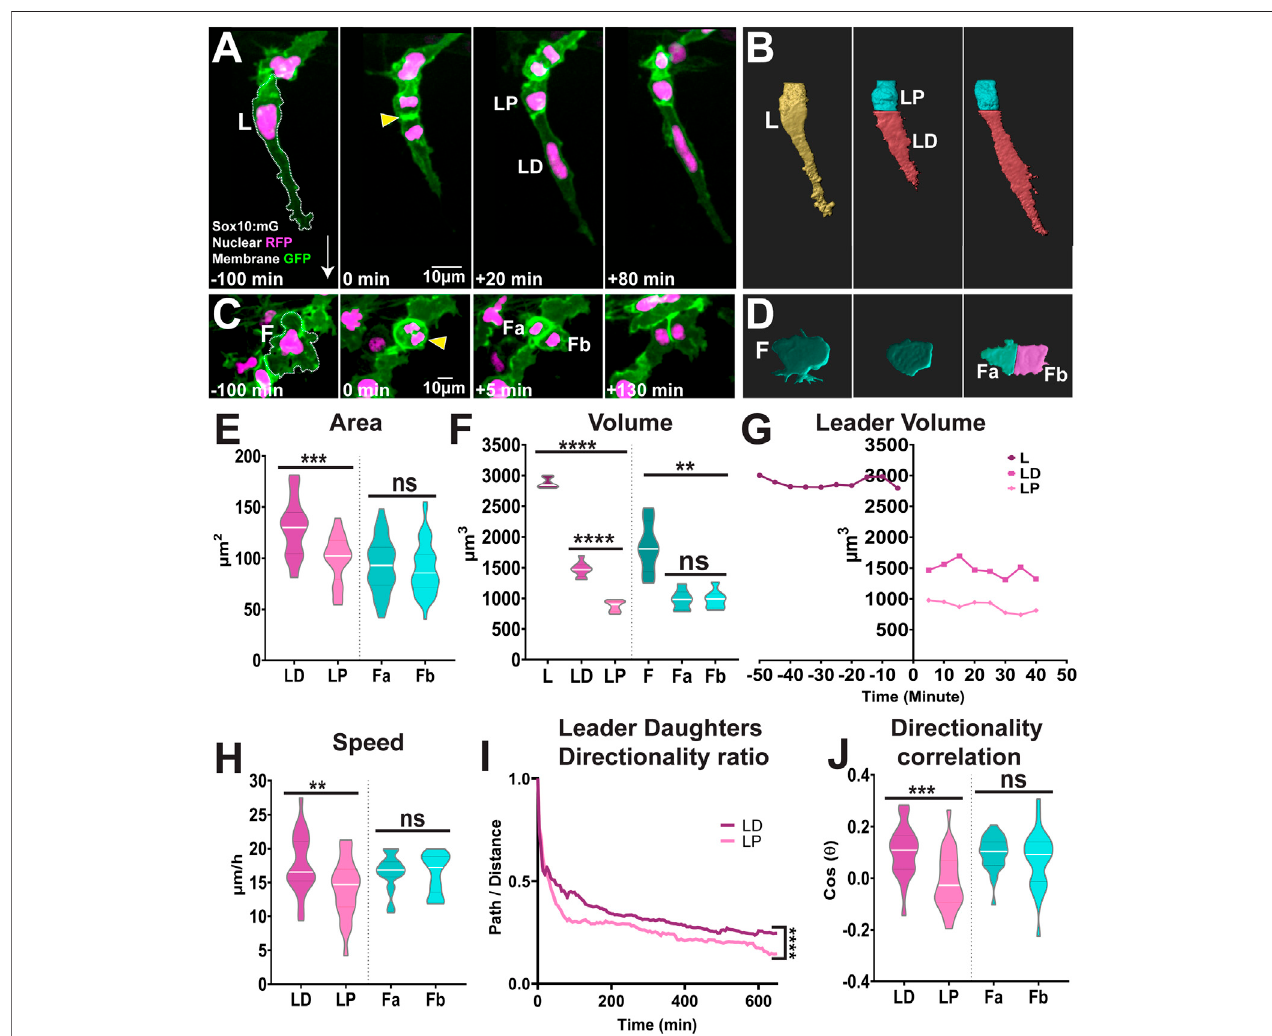
FIGURE 4 | Leaders TNC divide asymmetrically while followers divide symmetrically (A,B) Confocal images of Sox10:mG (A) and 3D rendering (B) of leader asymmetric division into distal and proximal daughters. L: Leader, LD: Leader Distal, LP: Leader Proximal; white arrow indicates direction of migration and yellow arrowhead points to the dividing cell (C,D) Confocal images of Sox10:mG (C) and 3D rendering (D) of follower symmetric division. F: Follower, Fa and Fb Follower ’ s daughters (E) Quanti fi cation of cell area of leaders ’ and followers ’ daughters quanti fi ed immediately after division (n = 25 for leaders and n = 44 for followers; Unpaired t test, p = 0.0001 for LD vs. LP and p = 0.5852 for Fa vs. Fb) (F) Quanti fi cation of cell volume of leaders, followers and their daughters after division (n = 10 divisionsforleadersandn=10divisionsforfollowers;Brown-ForsytheandWelchANOVAtests, p < 0.0001forLvs.LDandLP, p < 0.0001forLDvs.LP, p =0.0012for Fvs.FaandFb, p > 0.9999forFavs.Fb) (G) Cellvolumeovertimeofarepresentativeleaderbeforeandafterdivision (H) Quanti fi cationofspeedofmovementofleaders ’ and followers ’ daughters (n = 25 for leaders and n = 44 for followers; Unpaired t test, p = 0.0072 for LD vs. LP, p = 0.8690 for Fa vs. Fb) (I) Directionality ratio of leaders